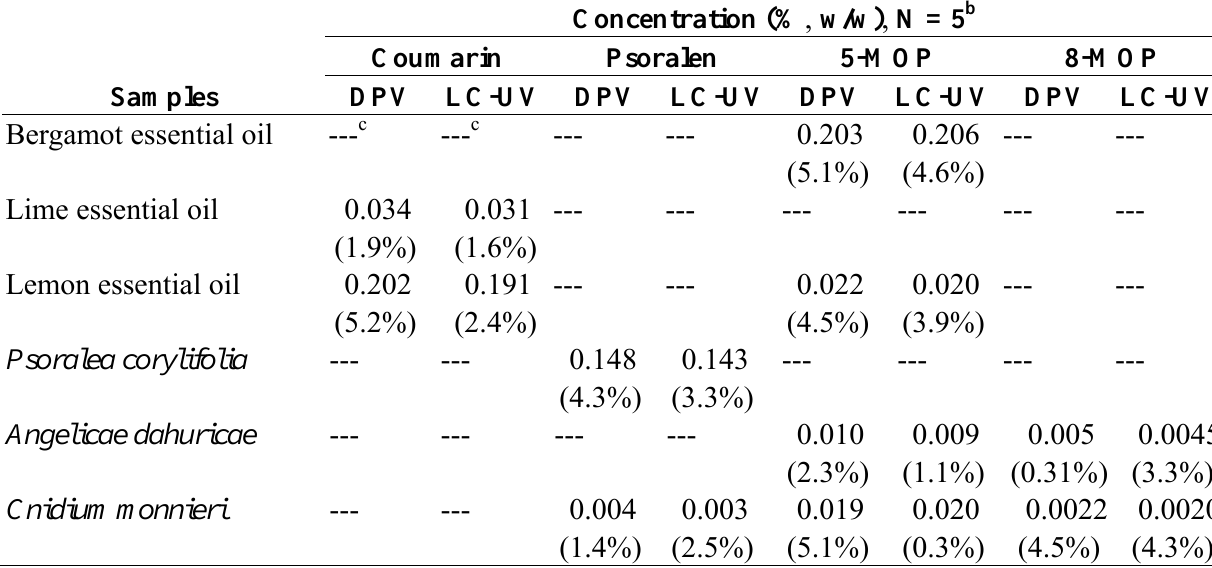
Table 3. Analytical results of determining coumarin levels in commercial pharmaceutical preparations using differential pulse voltammetry (DPV) and liquid chromatography with ultraviolet detection (LC-UV).